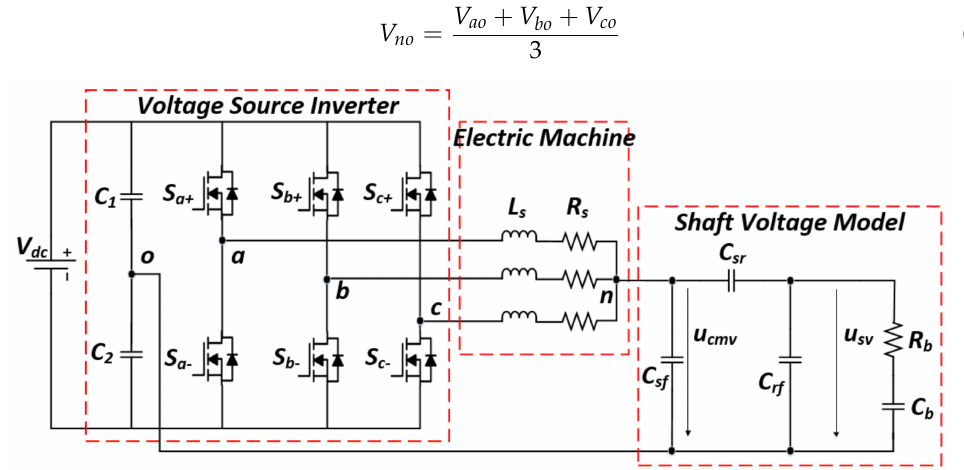
Figure 1. Topology of the vehicular electric drive